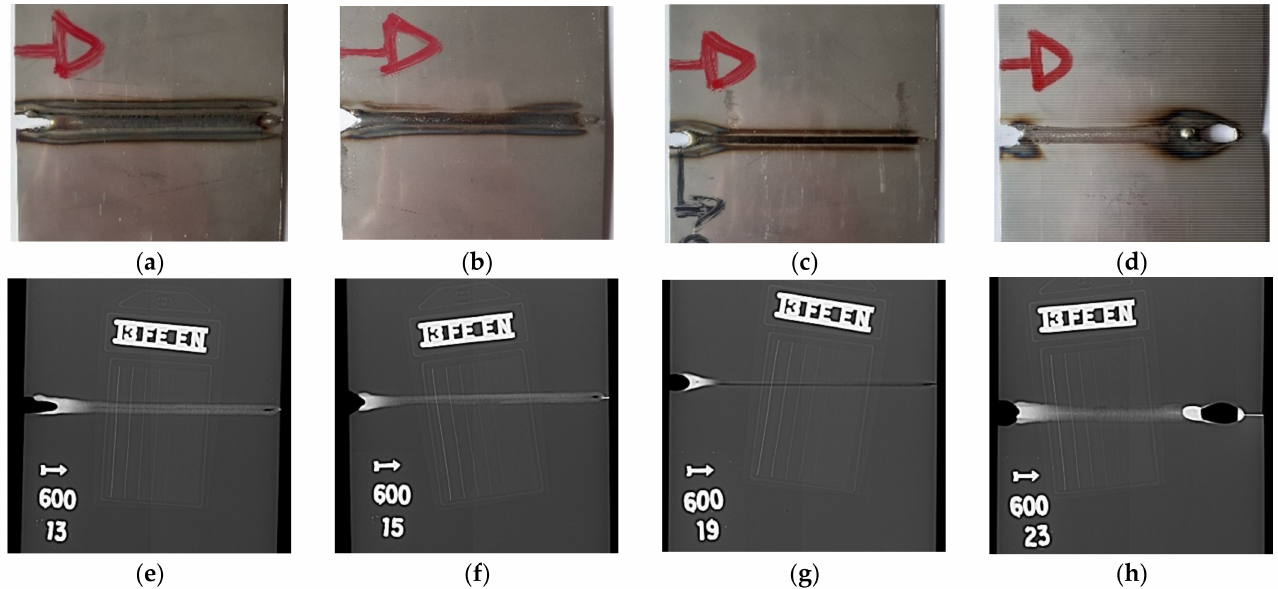
Figure 7. Selected welds and view of weld face: ( a ) sample S13, ( b ) sample S15, ( c ) sample S19, and ( d ) sample S23. Radiograms of the considered welds: ( e ) sample S13, ( f ) sample S15, ( g ) sample S19, and ( h ) sample S23.